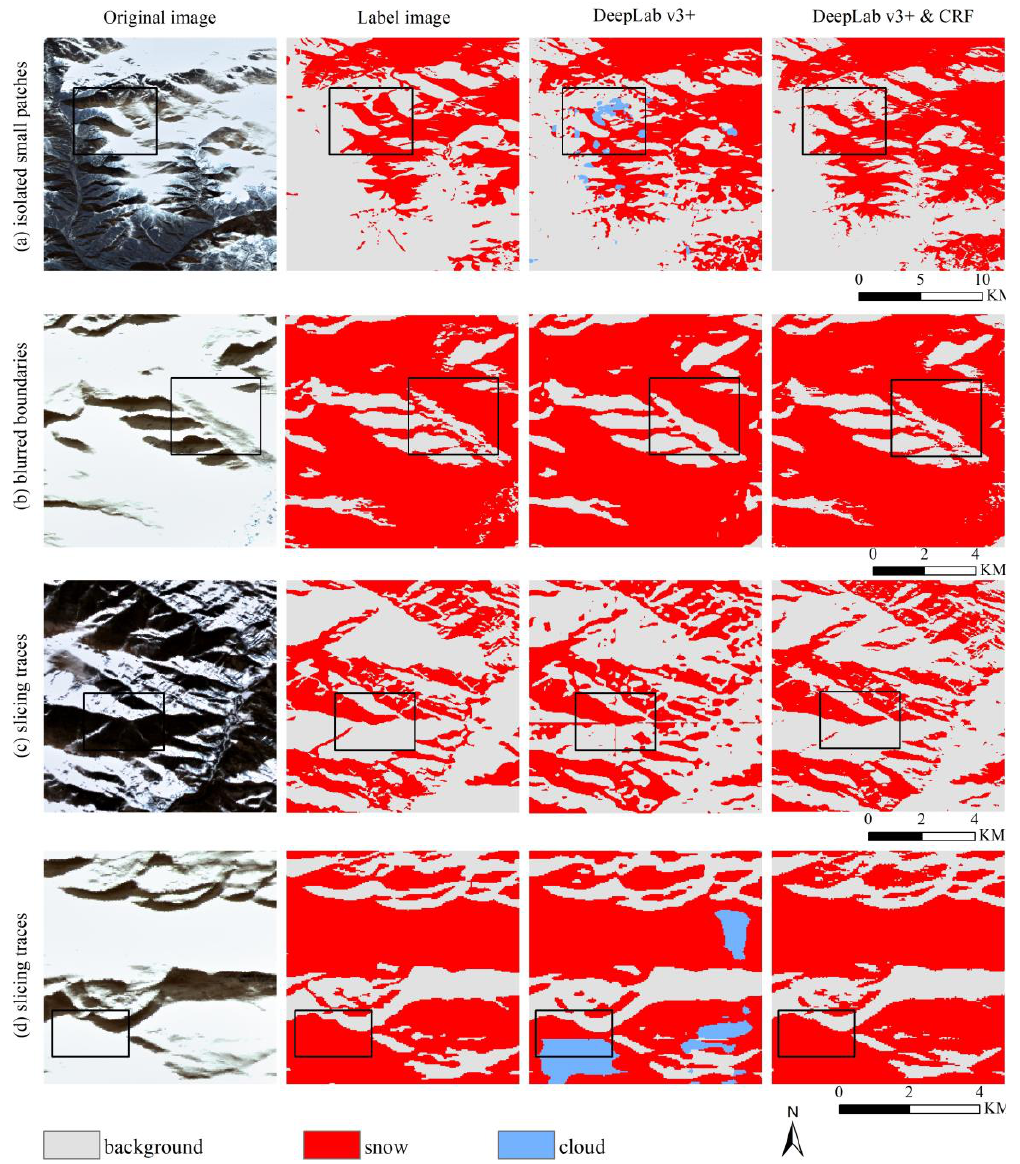
Figure 10. Post-processing cloud and snow identification comparison map (local details). The four lines of subfigures ( a – d ) represent the significant improvements of isolated small patches, blurred boundaries and slicing traces, respectively. The inside black rectangles show the corresponding areas where